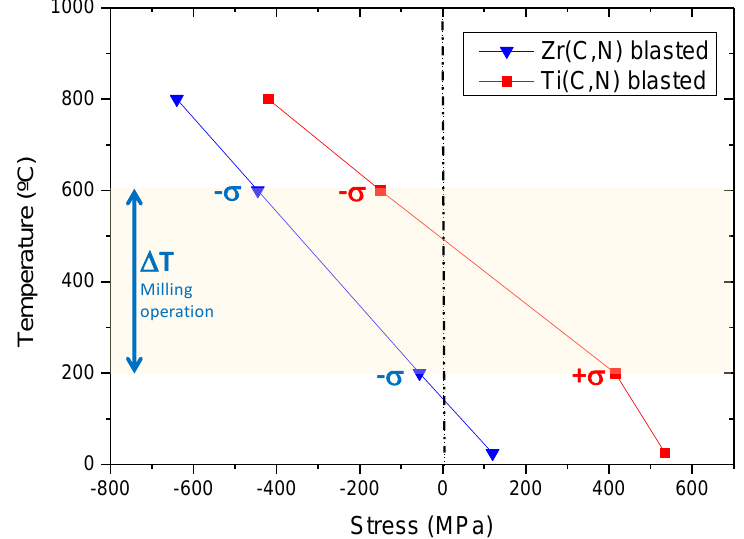
Figure 7. Reversible cycling stress amplitudes for the Zr(C,N) and Ti(C,N) layers (in Ti(C,N)/ α -Al 2 O 3 and Zr(C,N)/ α -Al 2 O 3 systems) determined by in-situ synchrotron measurements (temperature range: 25–800 ◦ C). The temperature fluctuation in wet milling of cast iron is highlighted. The reason is that the stress within the Zr(C,N) coating system remains mostly com- coating system, the stress state is reversible, varying between tensile (at lower tempera- tures) and compressive (at higher temperatures); a condition of oscillating cycling stresses (tensile-compressive-tensile) favorable for crack opening and